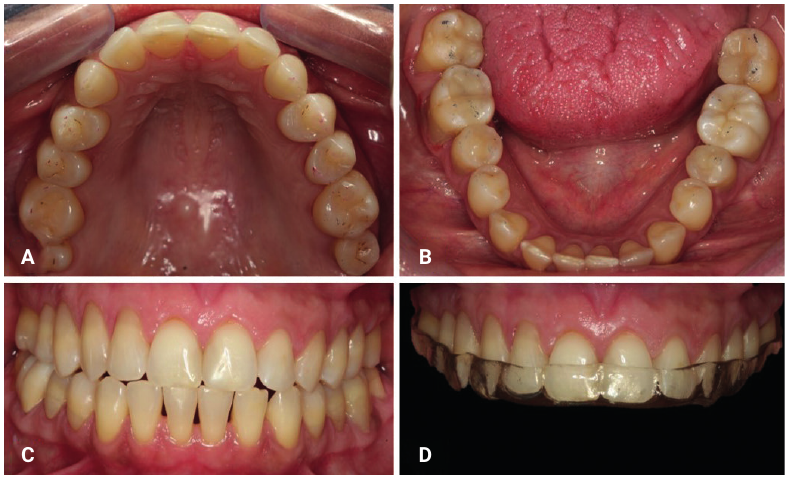
Figure 6. Final aspect of the restorations. (a) Occlusal view of maxillary teeth after termination of treatment showing well-distributed occlusal contact points (b) Occlusal view of mandibular teeth after treatment showing well-distributed occlusal contact points (c) Frontal view after treatment (d) Installation of the occlusal